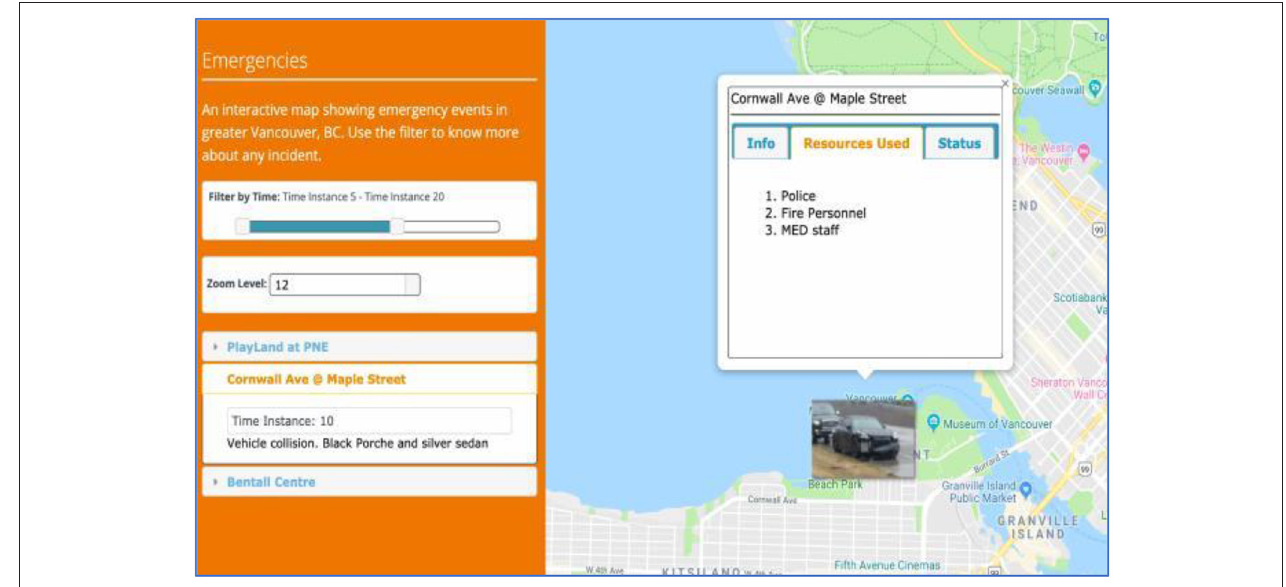
FIGURE 8 | Digital prototype map screen.